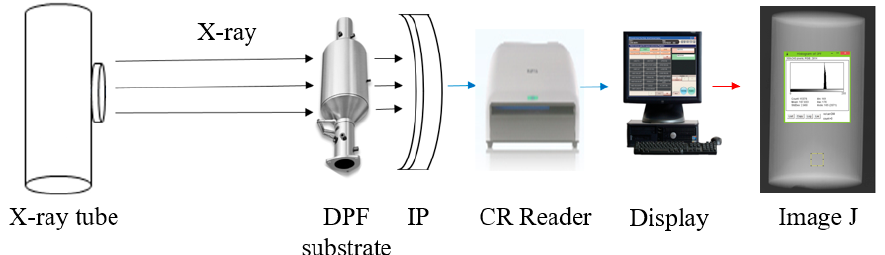
Figure 5. The schematic diagram from CR X-ray system to Image J.